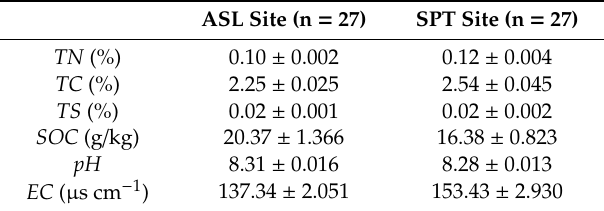
Table 1. Soil properties of the experimental sites.